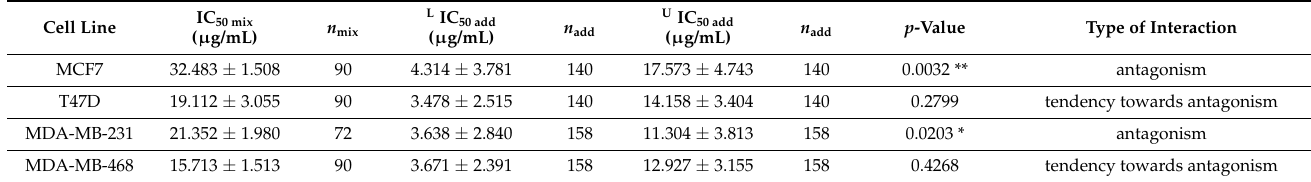
n mix —total number of items used at those concentrations whose expected anti-proliferative effects ranged between 16% and 84% (i.e., 4 and 6 probits) for the experimental mixture; n add —total number of items calculated for the additive mixture of the drugs examined; L —IC 50add value calculated from the equation for the lower line of additivity; U —IC 50add value calculated from the equation for the upper line of additivity. Statistical evaluation of data was performed with unpaired t -test with Welch’s correction. * p < 0.05 and ** p < 0.01 vs. the respective IC 50mix